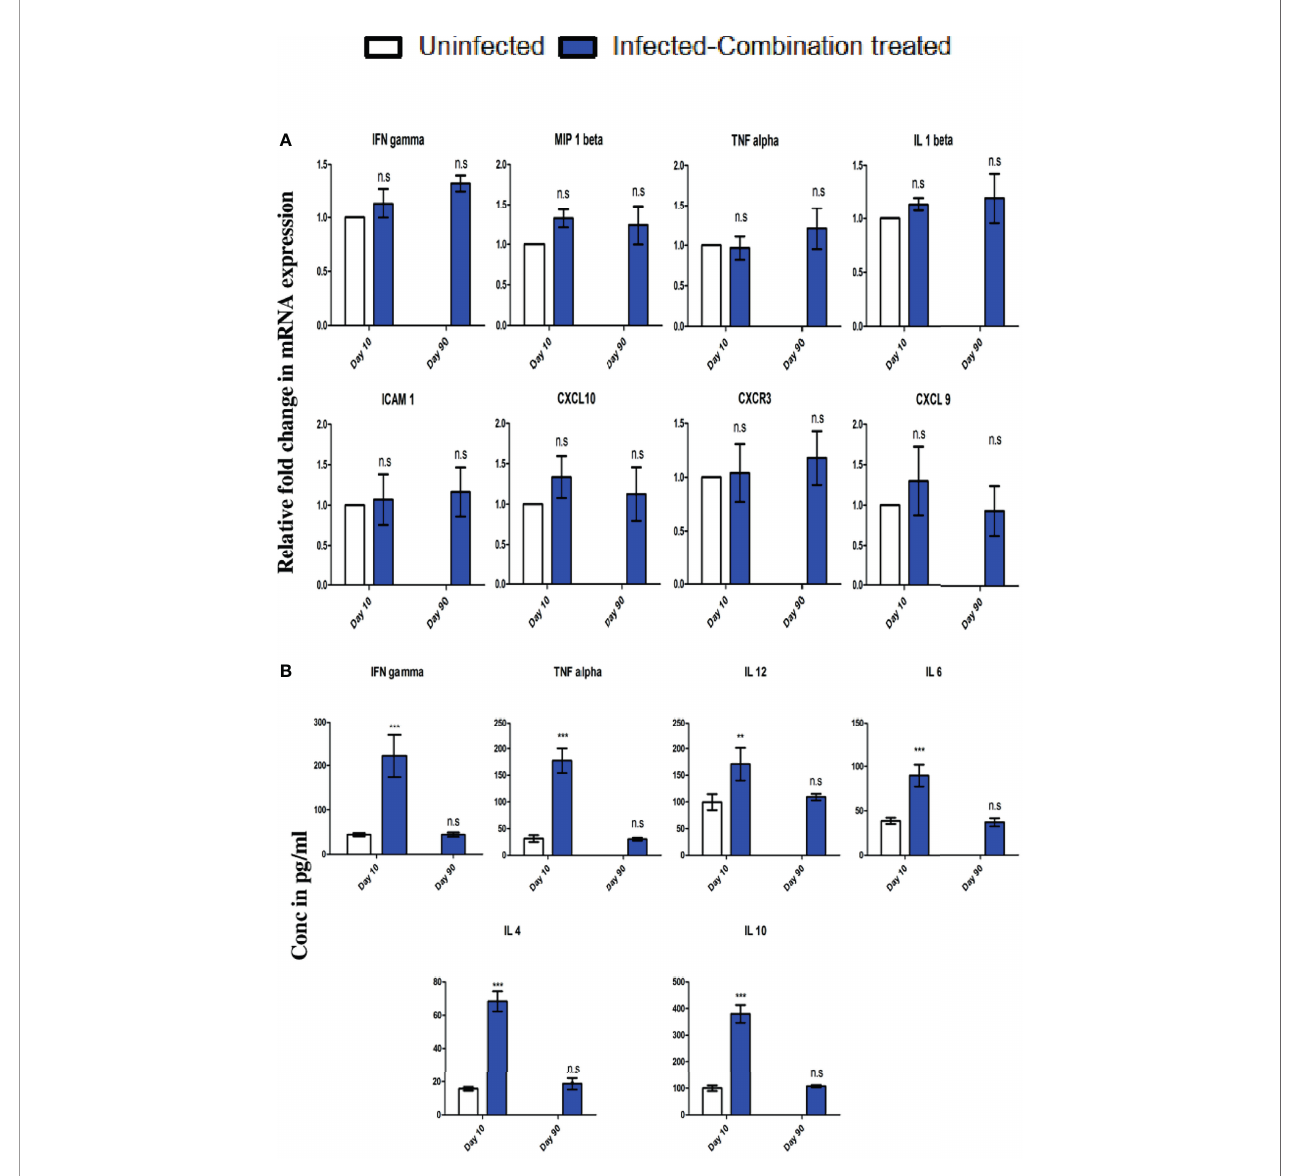
FIGURE 7 | C57BL/6 mice were infected and treated as described in legend for . (A) Changes in gene expression of IFN gamma, MIP 1beta, TNF alpha, IL 1beta, ICAM 1, CXCL 10, CXCR3 and CXCL 9 in the brain of infected-combination treated group on day 10 and day 90 p.i in comparison to uninfected group. Data is expressed as mean ± S.D of relative fold change in mRNA expression from 3 mice per group. (B) Changes in serum cytokine levels of IFN gamma, TNF alpha, IL 12, IL 6, IL 4 and IL 10 of infected-combination treated group on day 10 and day 90 p.i in comparison to uninfected group. Data is expressed as mean ± S.D of serum cytokine concentrations from 3 mice per group. [* P <0.05, ** P <0.01, *** P <0.001, n.s., not signi fi